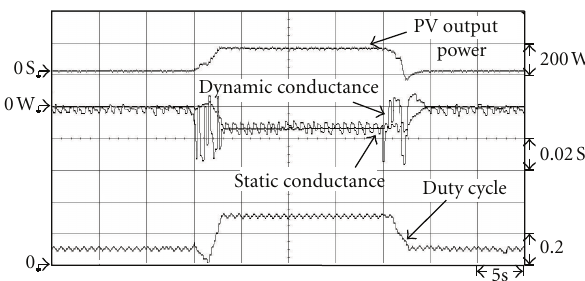
Figure 20: Measured output power, dynamic conductance, static conductance, and duty cycle waveforms of a PV module array using the proposed extension method under irradiation that increased from 450W/m 2 to 750 W/m 2 and then dropped back to 450W/m 2